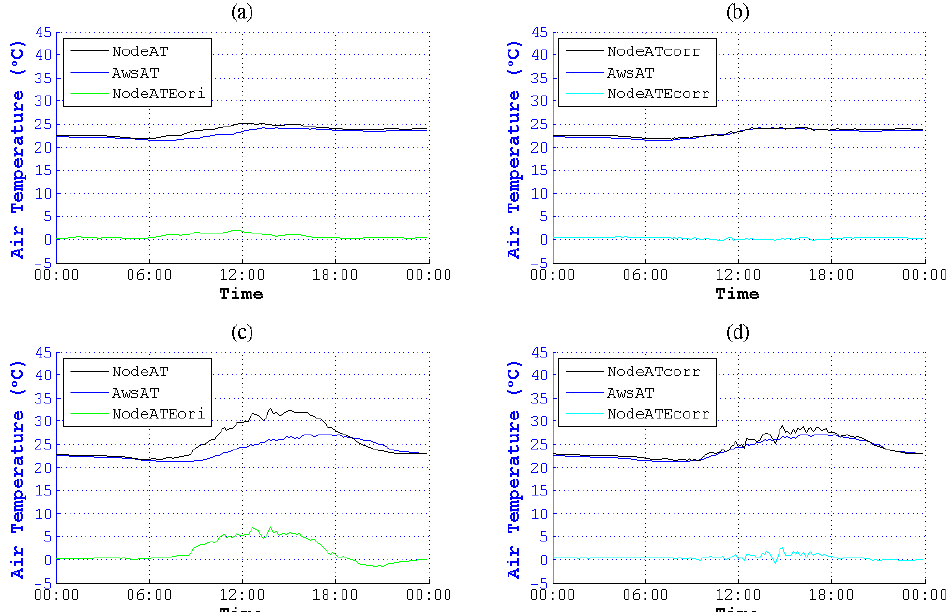
Figure 13. Contrast of NodeAT and NodeATcorr on 8 August 2014 and 10 August 2014. ( a ) Original data on 8 August 2014; ( b ) corrected data on 8 August 2014; ( c ) original data on 10 August 2014; ( d ) corrected data on 10 August 2014.